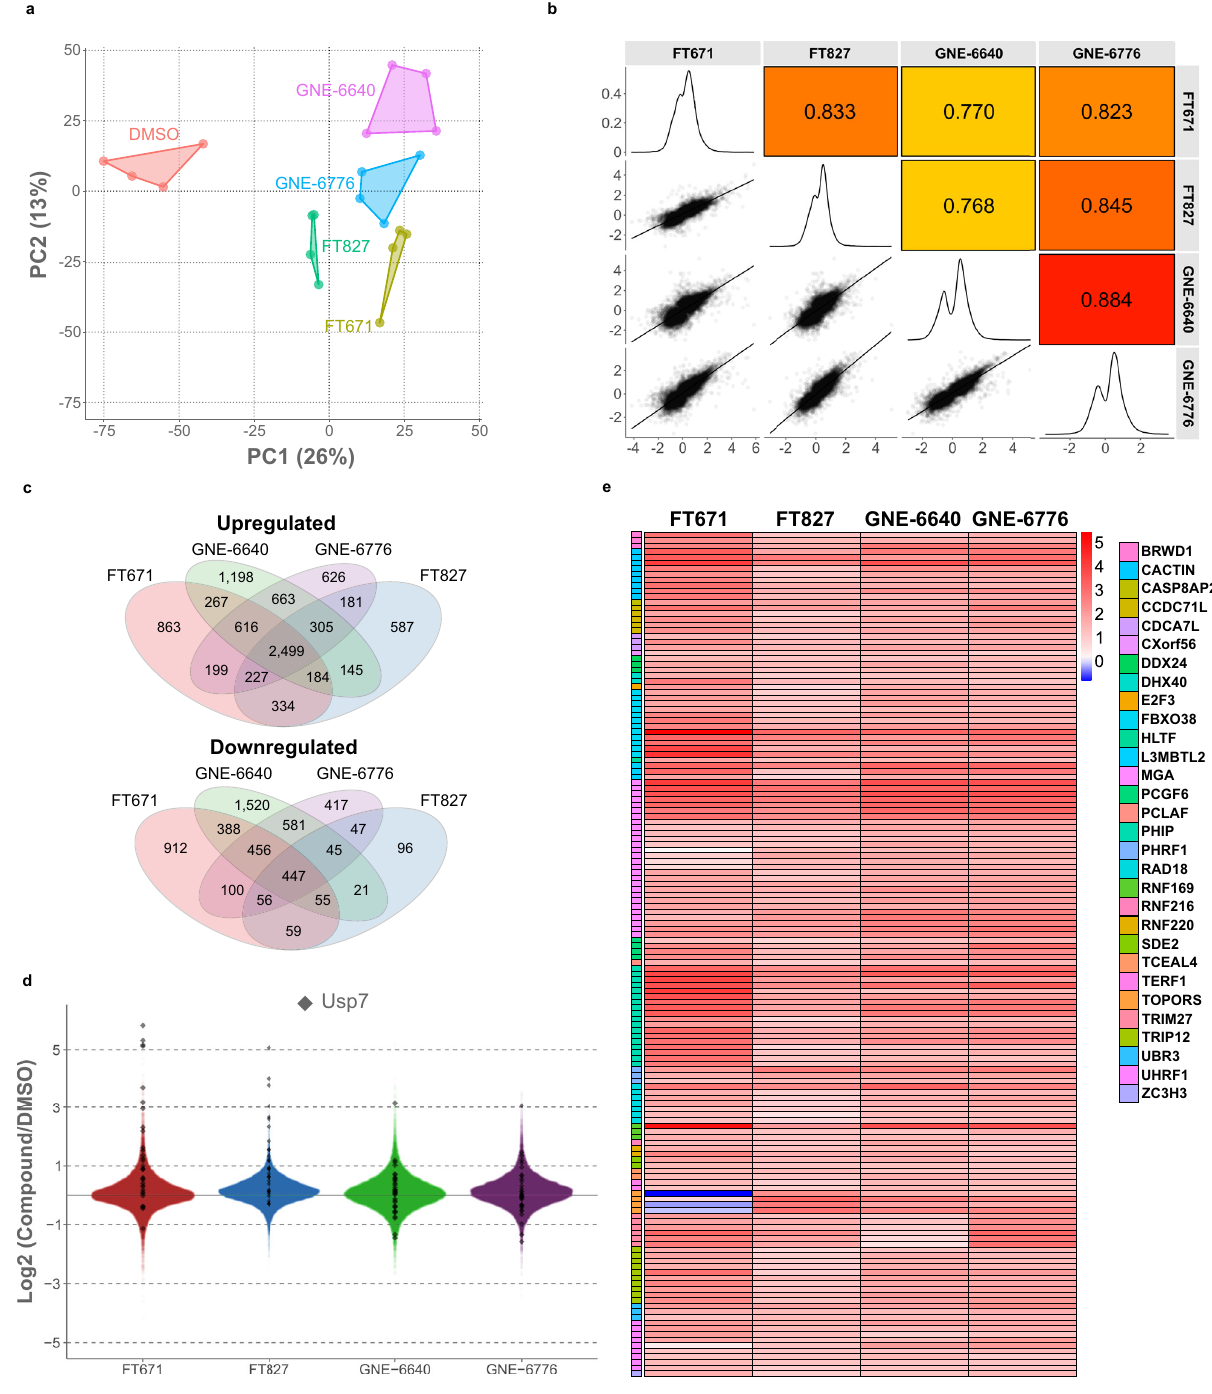
Fig. 5 Pro fi ling of multiple USP7-targeting compounds by DIA ubiquitinomics. a HCT116 cells were treated with four structurally distinct USP7 inhibitors for 1 h. Shown is a principal component analysis (PCA) of the ubiquitinomics data. b Log2 fold changes (lower left part), density distributions (middle part), and Pearson correlations of signi fi cantly regulated K-GG peptide intensities with four different compounds targeting USP7. c Venn diagrams of signi fi cantly up- and downregulated K-GG peptides with the different compounds. d Dot plot showing Log2 fold changes (USP7-targeting compound vs DMSO) of K-GG peptides for FT671, FT827, GNE-6640, and GNE-6776. K-GG peptides mapping to USP7 are highlighted. e Fold changes of ubiquitinated peptides (FT671/DMSO, Log2-transformed) for four structurally distinct USP7 inhibitors. Shown are ubiquitin peptide pro fi les for those proteins that harbor signi fi cantly and >2-fold increased ubiquitination sites with three out of four USP7 inhibitors and that are ubiquitinated and degraded upon FT671 treatment (see Fig. 4). Source data are provided as a Source Data fi